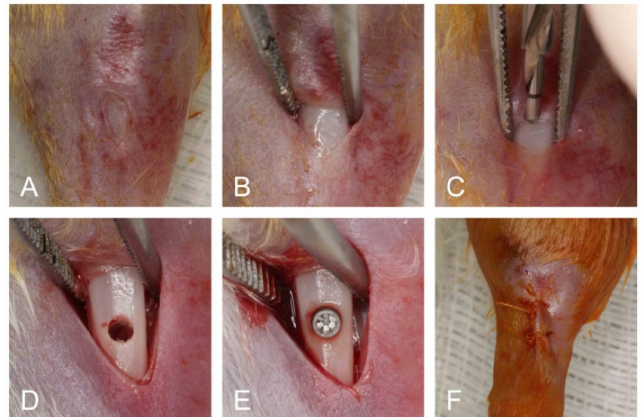
Figure 1. Surgical procedures ( A – F ). Initial aspect of tibia after trichotomy and antisepsis ( A ). Exposed bone tissue after full-thickness flap ( B ). Osteotomy being performed ( C ). Bone before implant placement ( D ). Mini implant installed ( E ). Flap sutured ( F ).